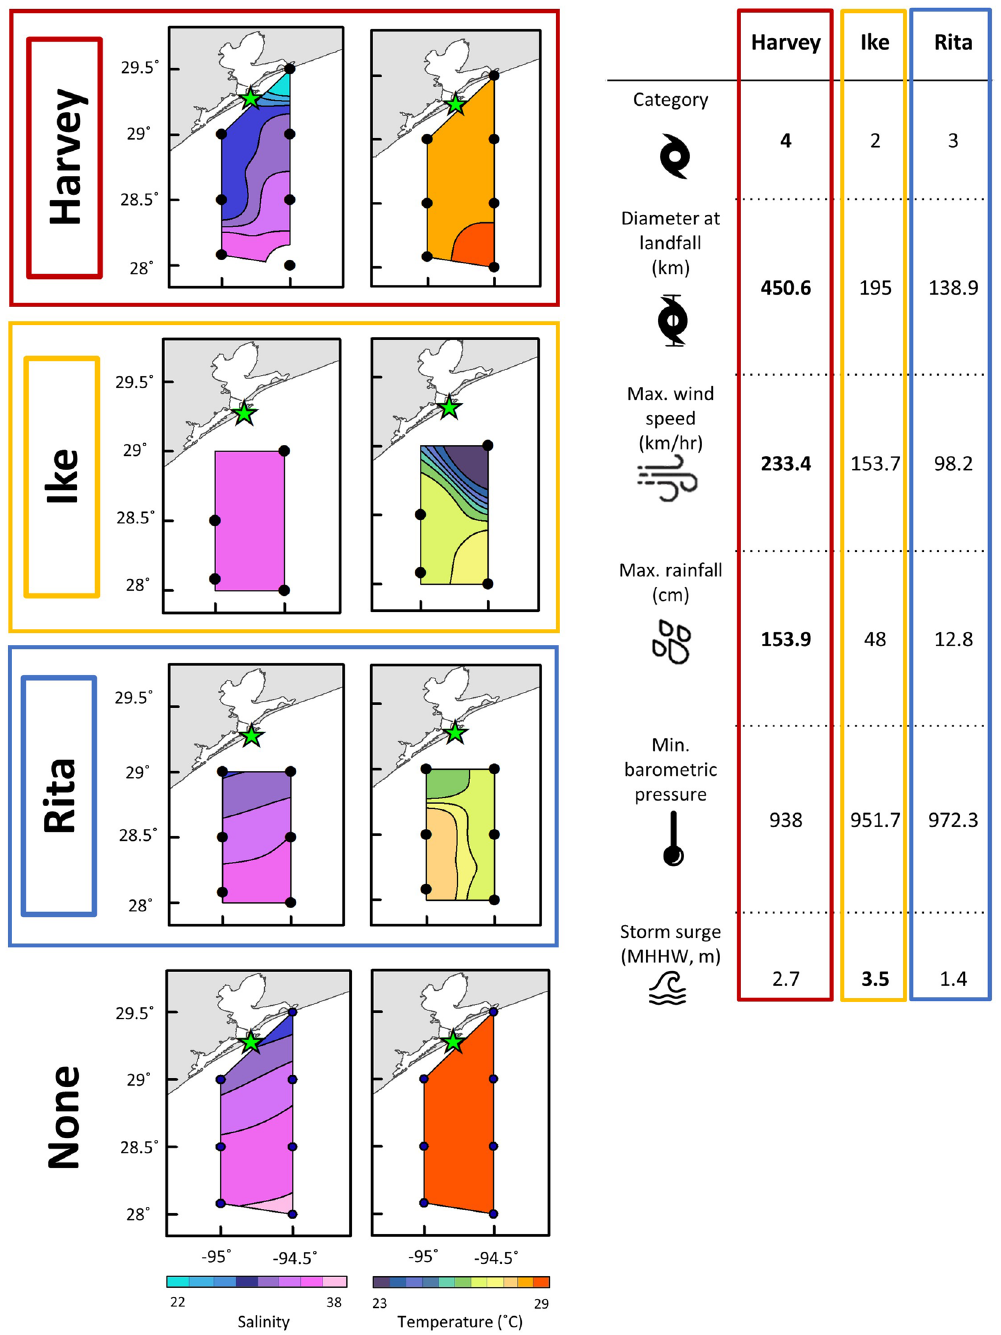
Figure 1. Spatial patterns of salinity (left, psu) and temperature (right, °C) recorded following Hurricanes Harvey (red), Ike (yellow), and Rita (blue) in the NWGOM off the coast of Galveston Bay, Texas (green star) compared to ‘non-storm’ conditions (bottom). Unique characteristics of each cyclone are displayed adjacent with maximum values in